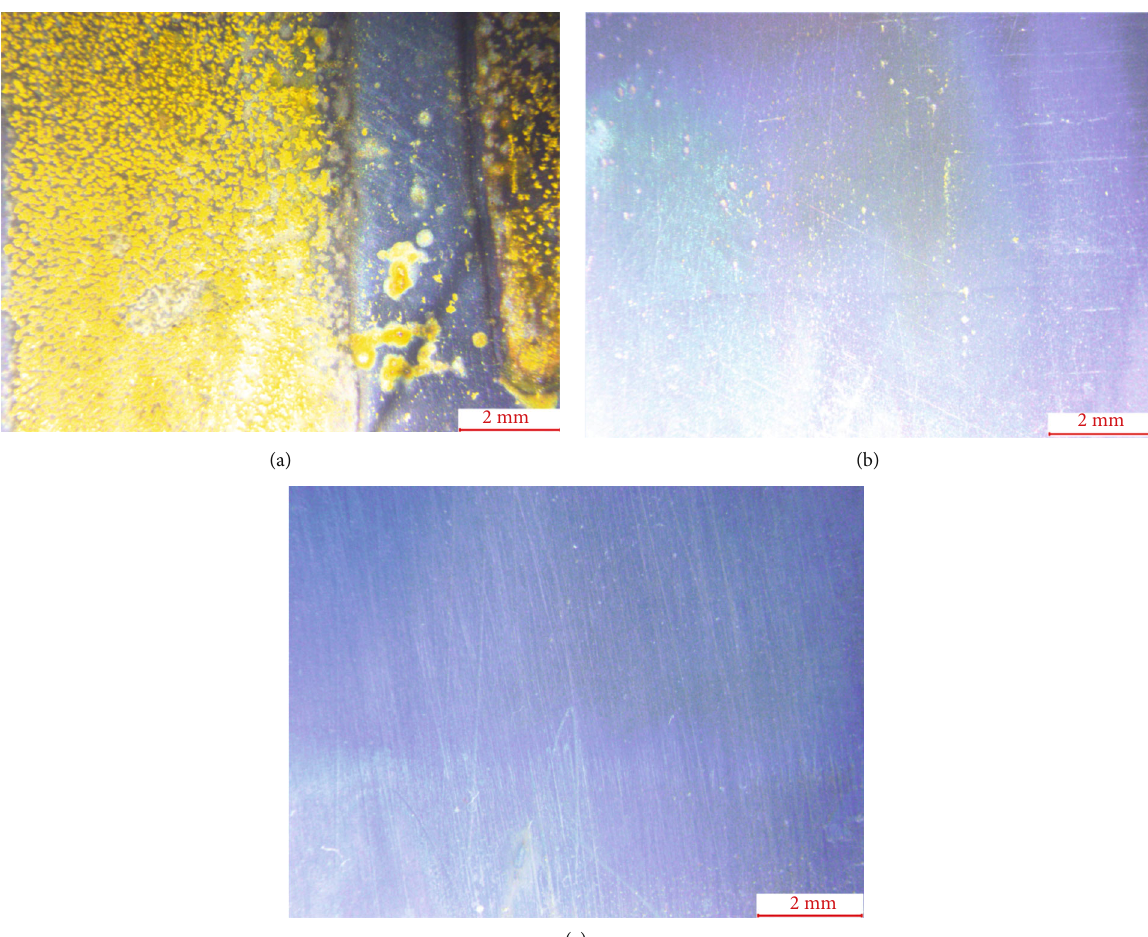
Figure 7: The optical image of 09G2S steel surface after 24 hours of exposure to 0.1% NaCl solution: (a) uninhibited, (b) inhibited by sodium citrate at a concentration of 2g/l, and (c) inhibited by sodium citrate at a concentration of